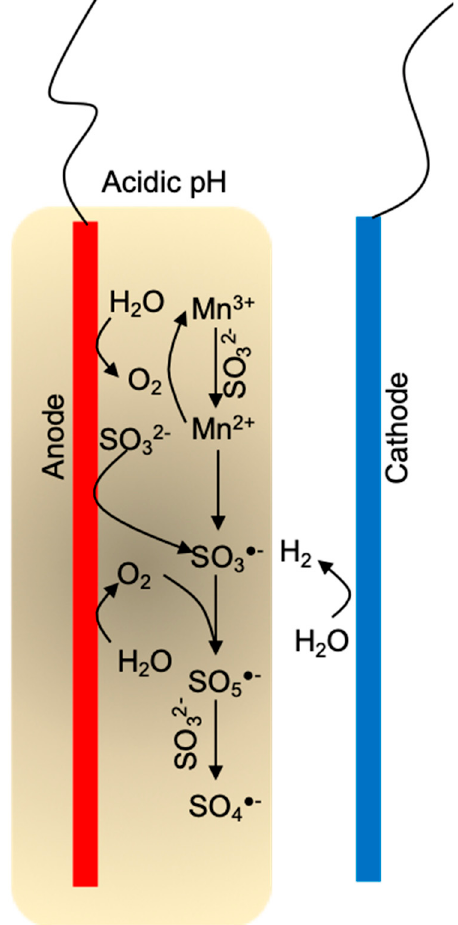
Figure 9. Schematic reaction mechanism of the electro/Mn(II)/sulfite process.